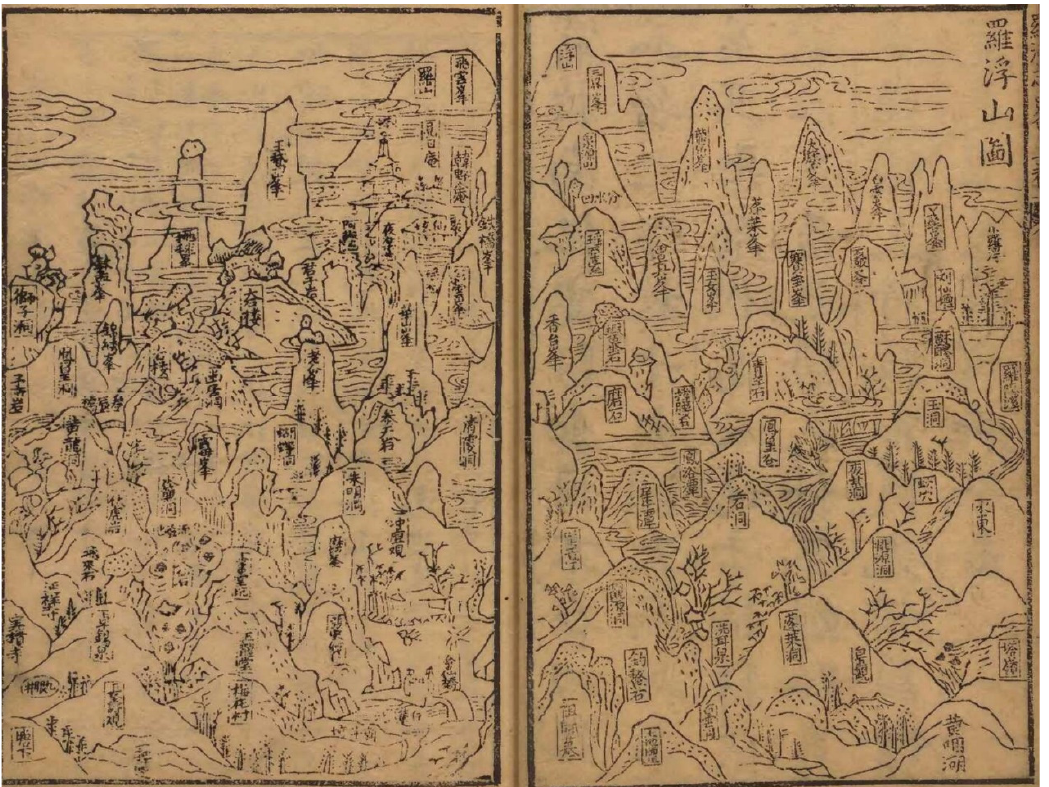
Figure 10. Panorama of the Luofu Mountains, 1607. Woodblock print. After Han Mingluan, Luofu zhi lue , 1.10b-11a.